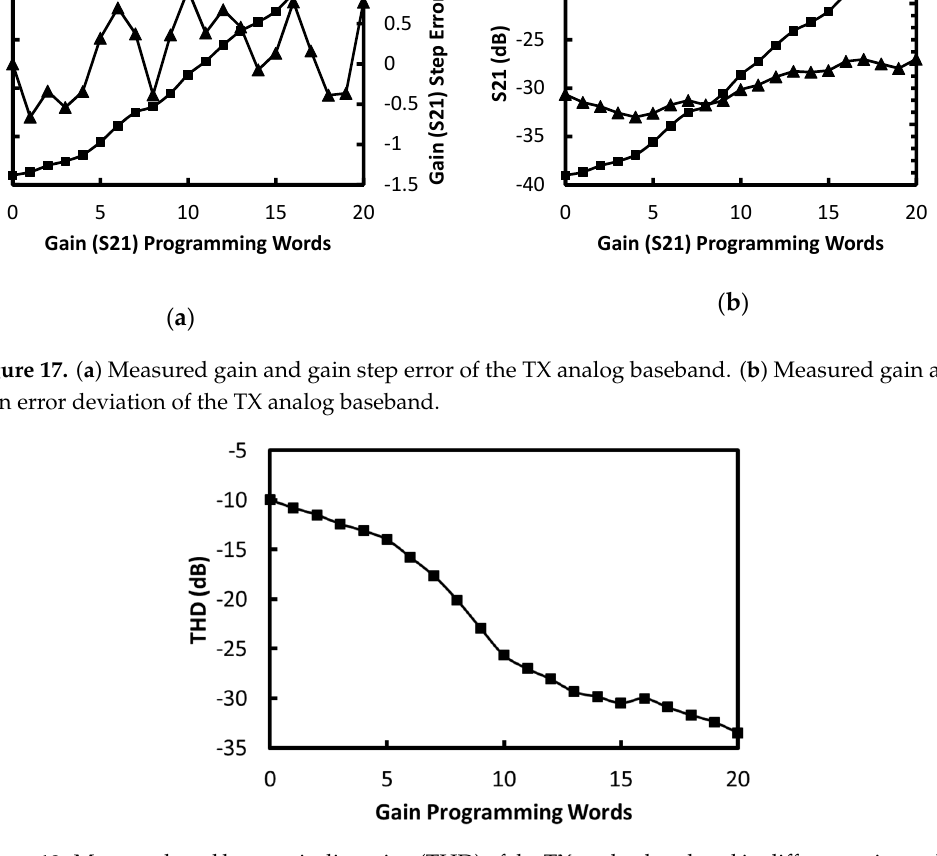
Figure 18. Measured total harmonic distortion (THD) of the TX analog baseband in different gain modes.